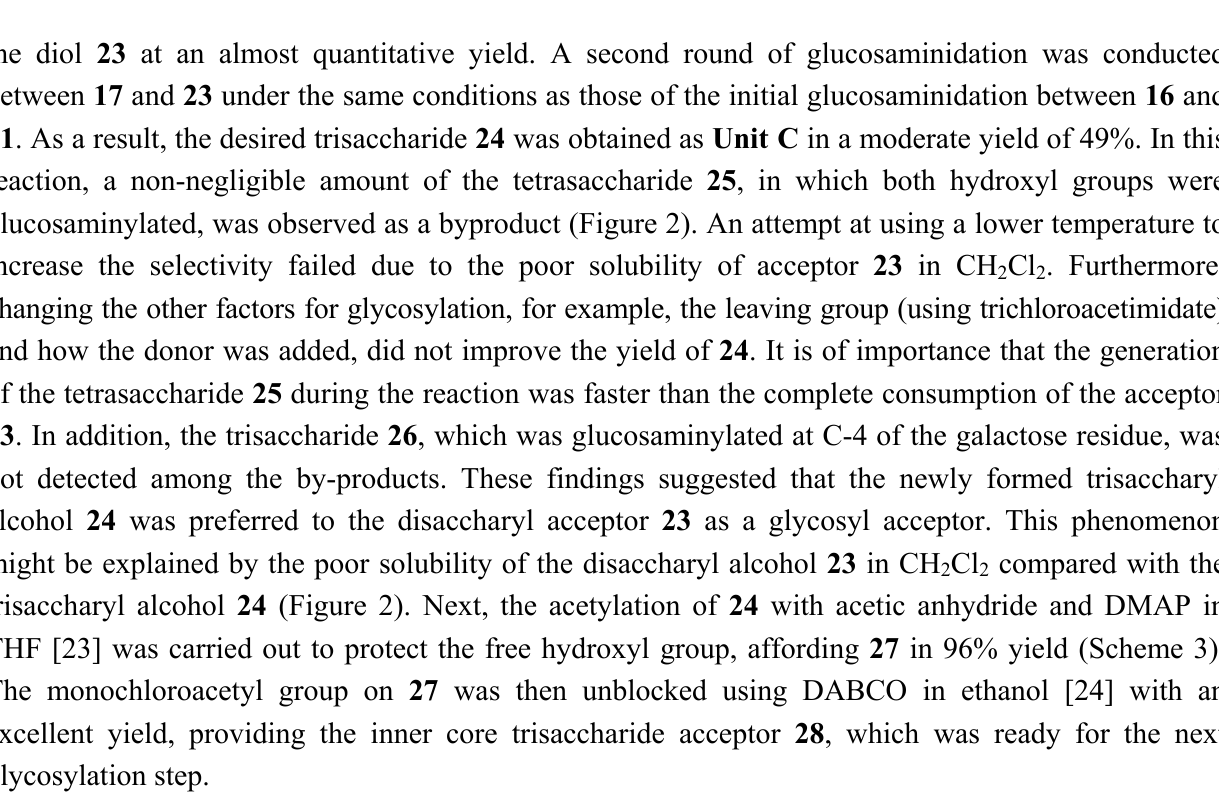
Figure 2. Explanation for the poor regioselectivity observed during